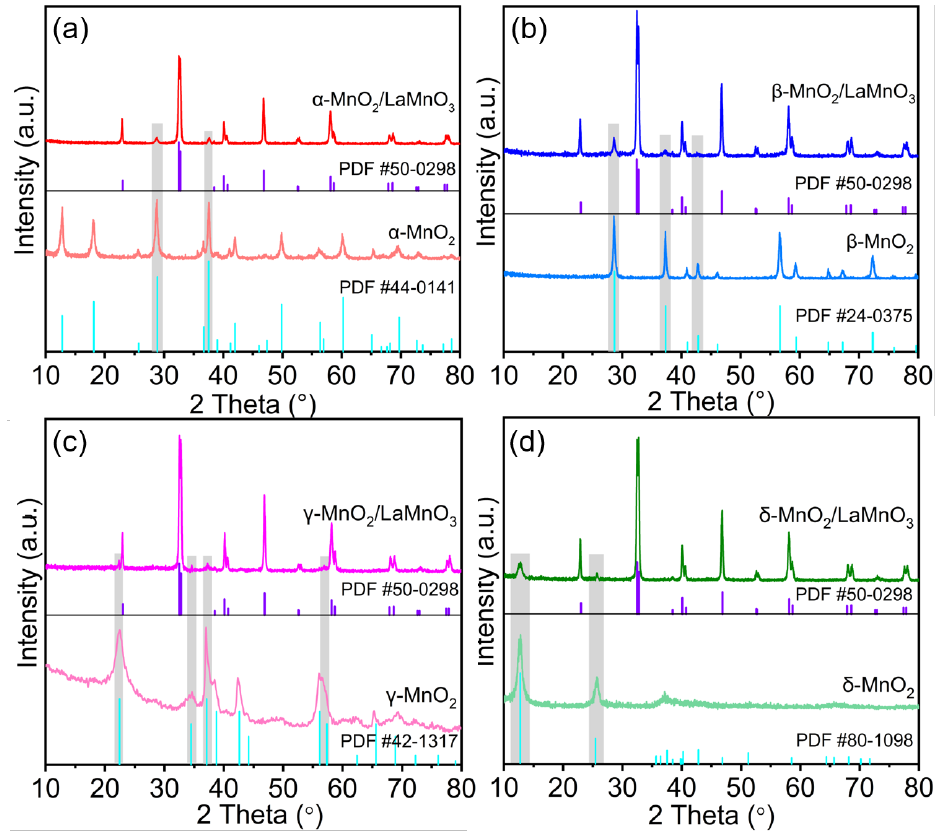
Figure 1. XRD patterns of ( a ) α - MO/LMO, α -MnO 2 and corresponding standard PDF card diffraction profile; ( b ) β - MO/LMO, β -MnO 2 and corresponding standard PDF card diffraction profile; ( c ) γ - MO/LMO γ -MnO 2 and corresponding standard PDF card diffraction profile; and ( d ) δ -MO/LMO, δ -MnO 2 and corresponding standard PDF card diffraction profile.